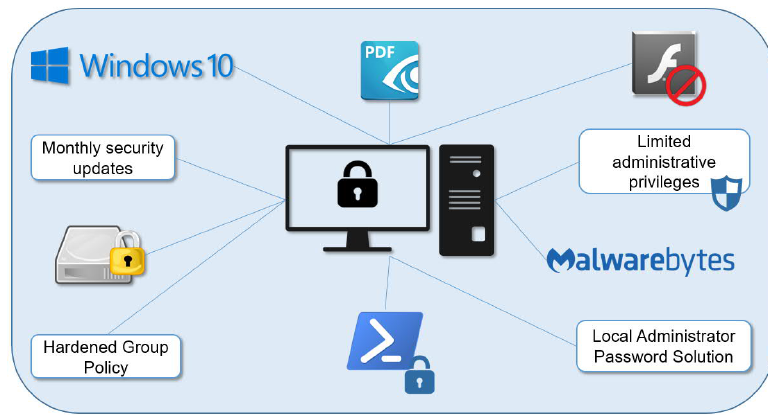
Fig 5. Hardened PC